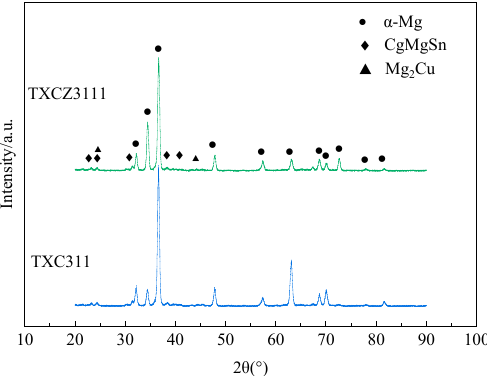
Figure 3. XRD patterns of TXC311 and TXCZ3111 homogeneous alloys.